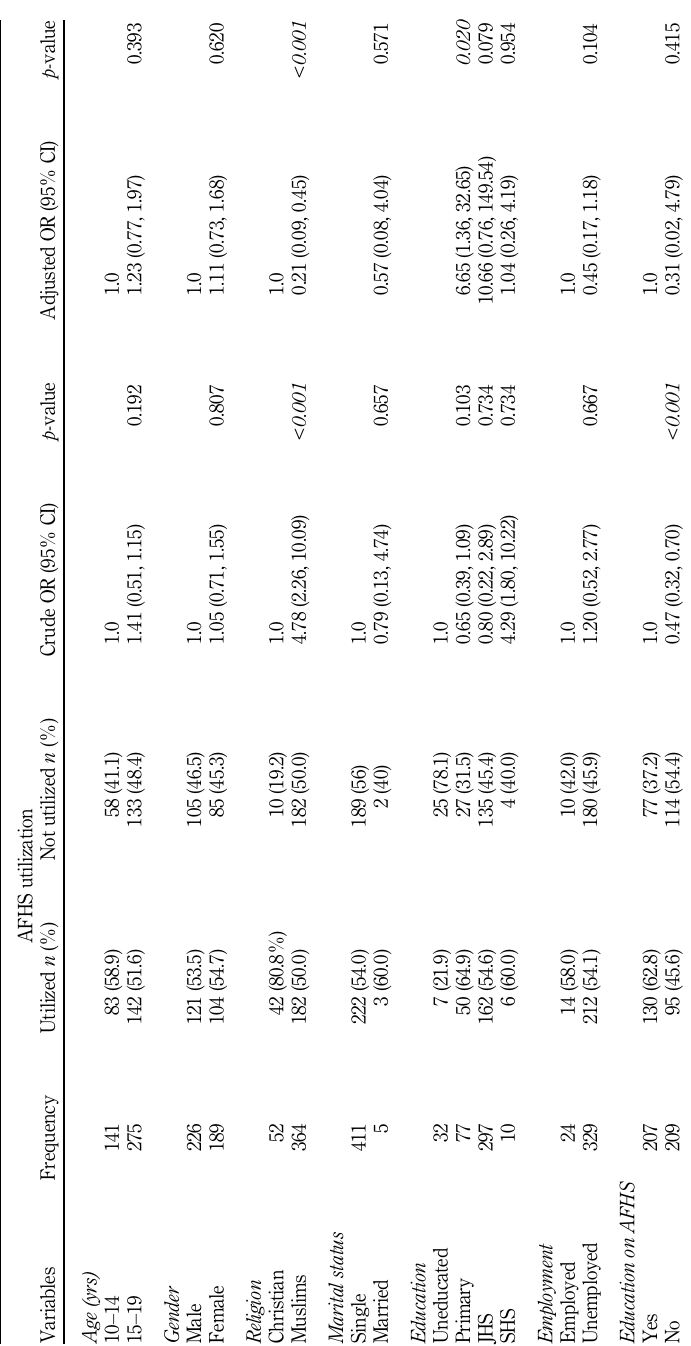
Table 4. Factors associated with AFHS utilization inKumbungu( n 5